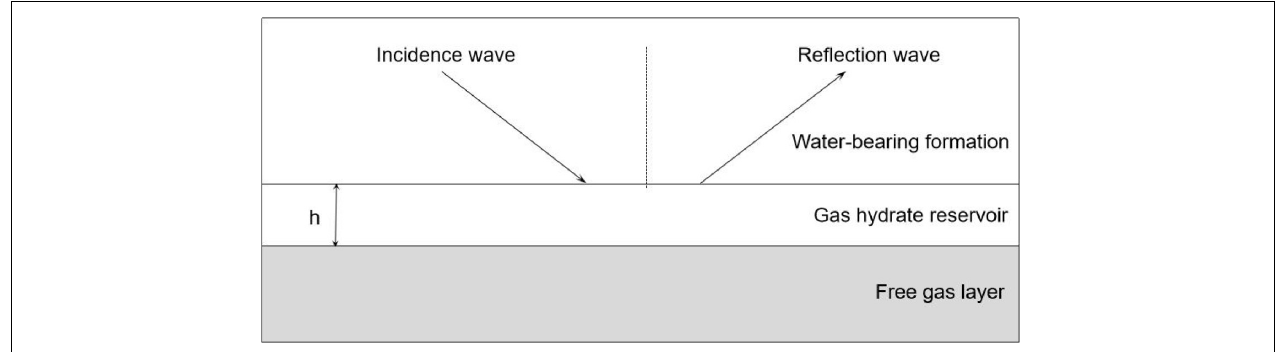
FIGURE 7 | Geological models of a gas hydrate-bearing sediment.